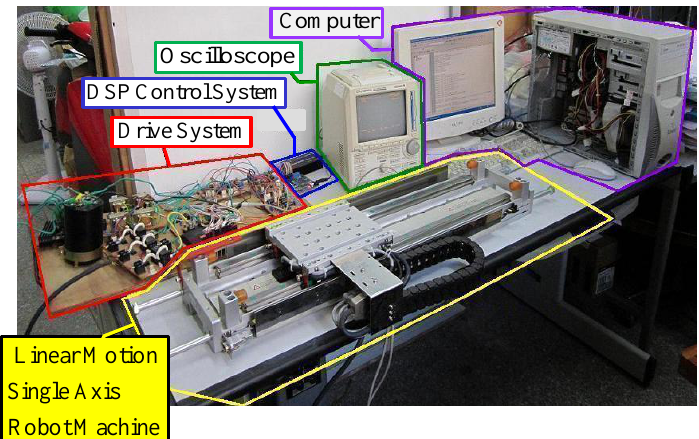
Figure 5. A picture of the experimental set-up of the linear motion single axis robot machine drive system.